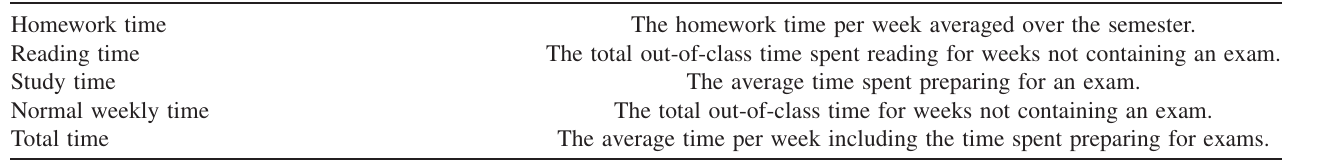
TABLE I. Summary of composite